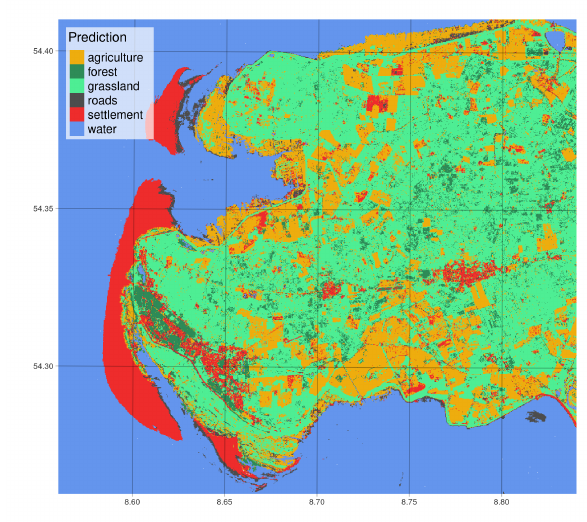
Figure 3. Landcover classification of the coastal area depicted in Figure 4. Sentinel-2 true color composite of a coastal area in Fig. 4 as predicted by the simplified model after spatial variable Germany with the location of test polygons and the associated selection landcover class. Polygon locations are shown as centroid points for visualization